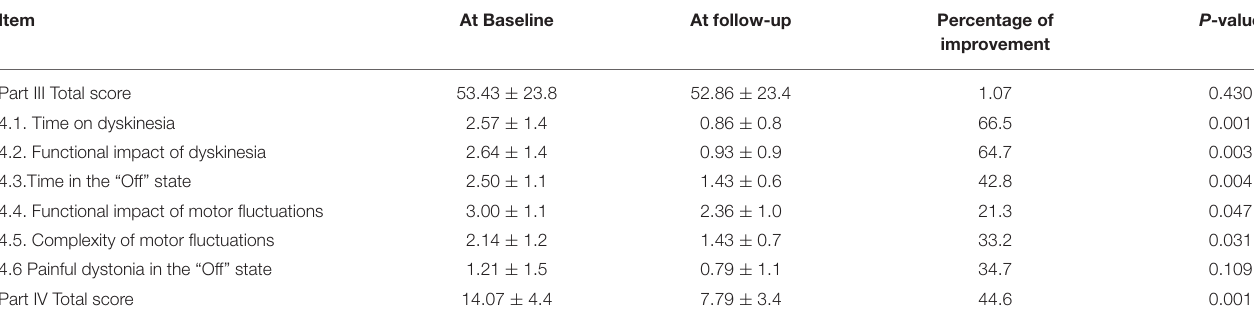
TABLE 2 | Comparison of scores related to the movement disorders society unified Parkinson’s disease rating scale parts III and IV items, before and after treatment. Item At Baseline At follow-up Percentage of